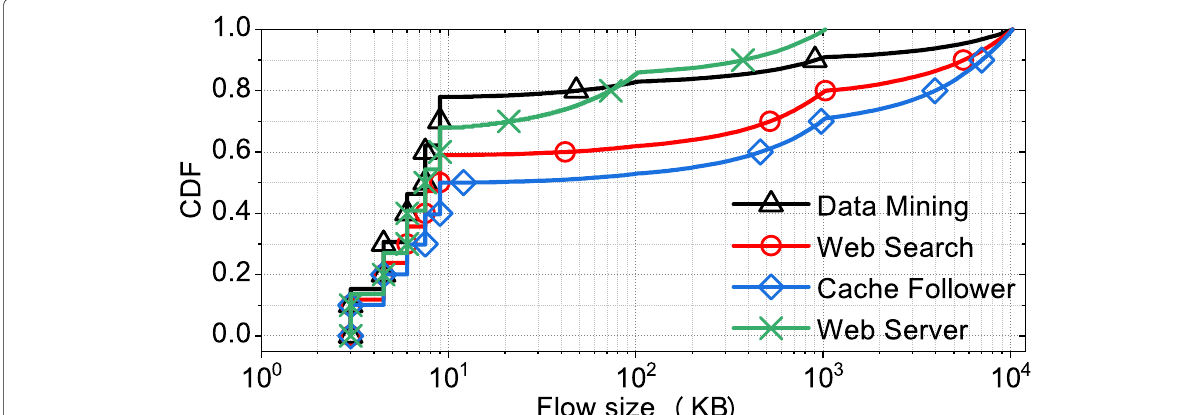
Fig. 10 The CDFs (Cumulative Distribution Functions) of flow size under realistic workloads